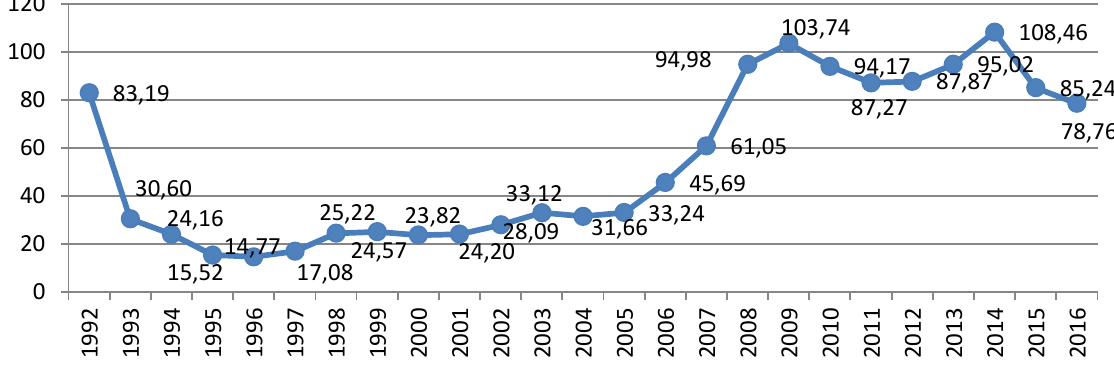
Figure 3. Domestic loans provided by the financial sector in Ukraine , % of GDP